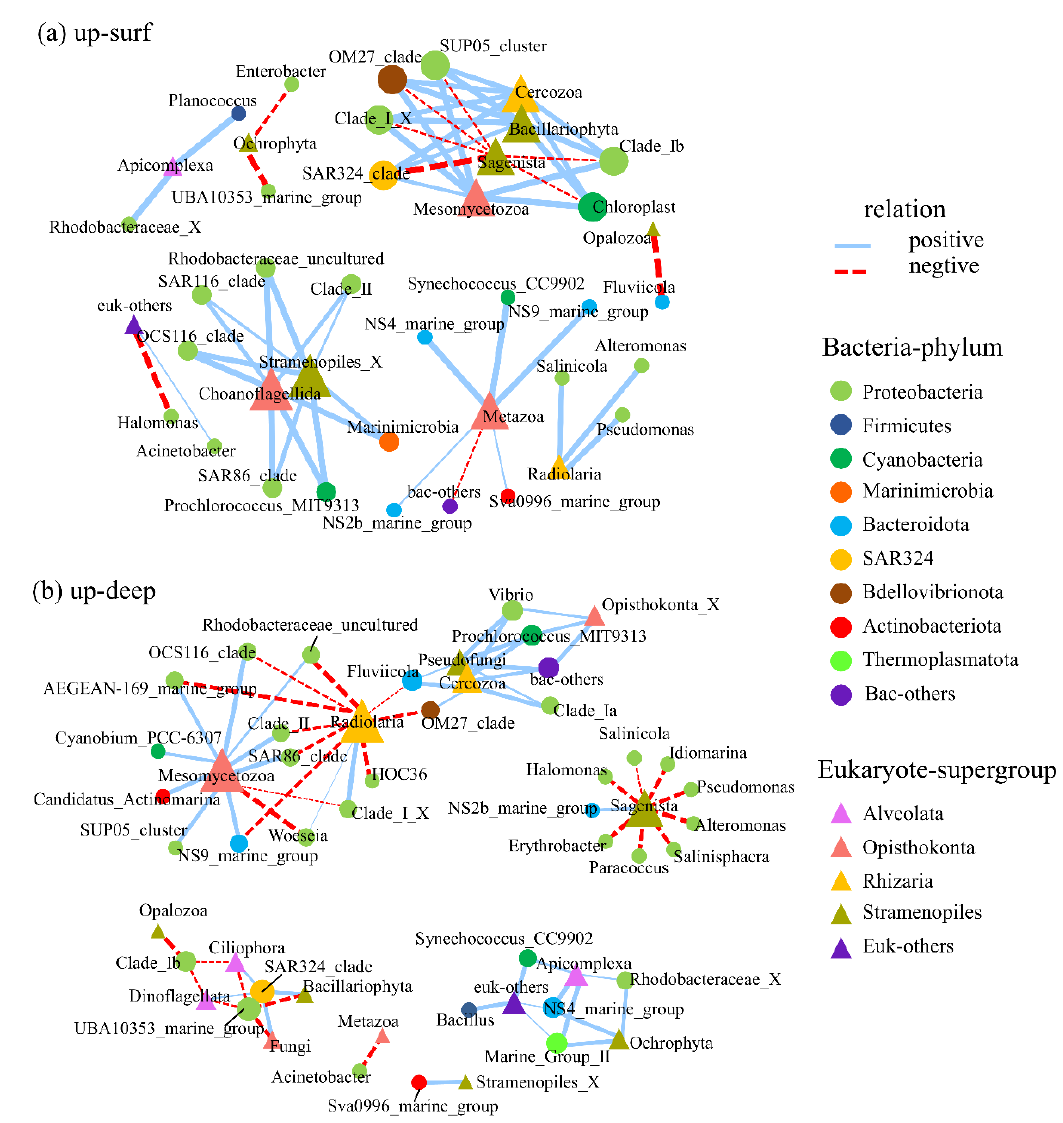
Figure 5. Network analysis of associations between bacterioplankton and microbial eukaryotes in ( a ) surface water and ( b ) deep water. The different bacterioplankton genus and microbial eukaryote phyla are represented by circles and triangles with distinctive colors, respectively. The size of the nodes represented the relative abundances of each microbe. The blue and red lines between the nodes represent positive or negative correlations, respectively. The thickness of the line represents the strength of correlation.